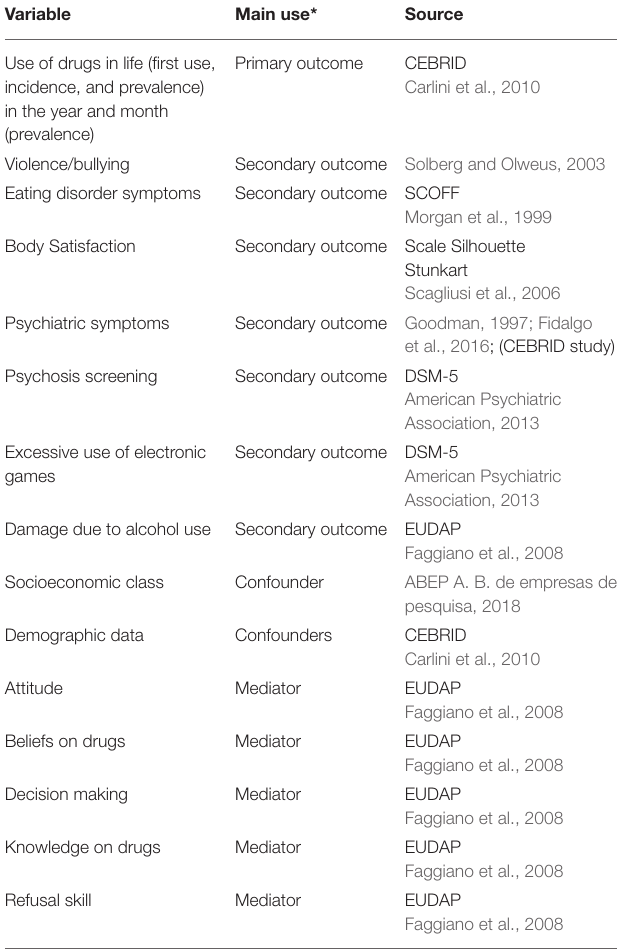
TABLE 1 | Details of questionnaire modules on knowledge, attitude, and behaviors related to alcohol, tobacco, and other